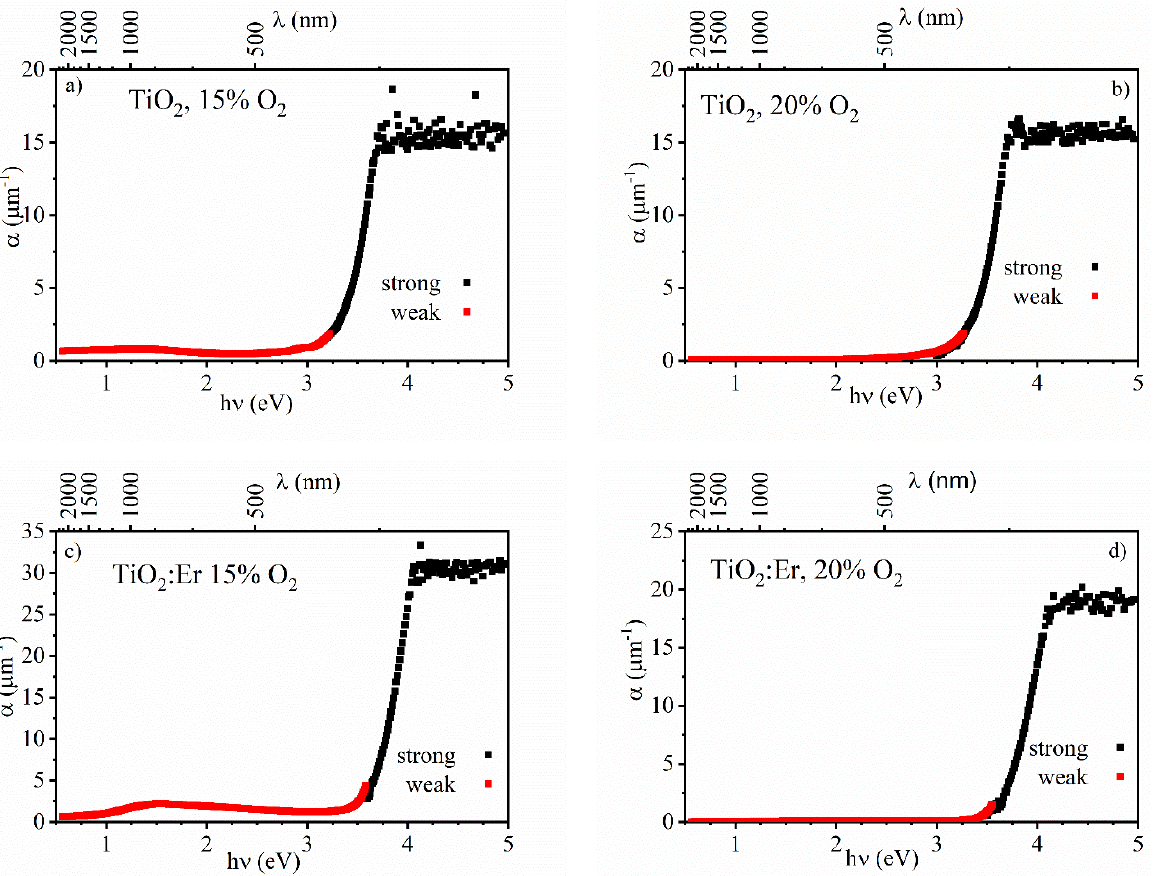
Figure 8. Spectral dependence of the absorption coefficient α of thin films: undoped TiO 2 ( a ) 15% O 2 and ( b ) 20% O 2 , and TiO 2 :Er ( c ) 15% O 2 and ( d ) 20% O 2 .